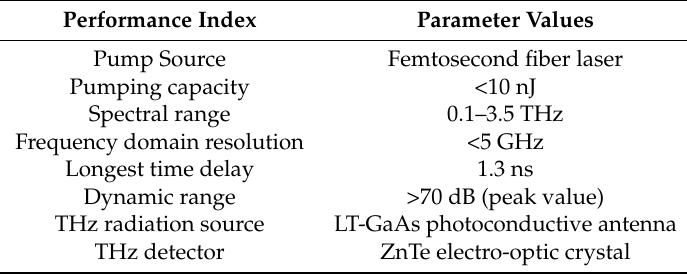
Table 1. System parameters of the Z3 THz-TDS (time domain